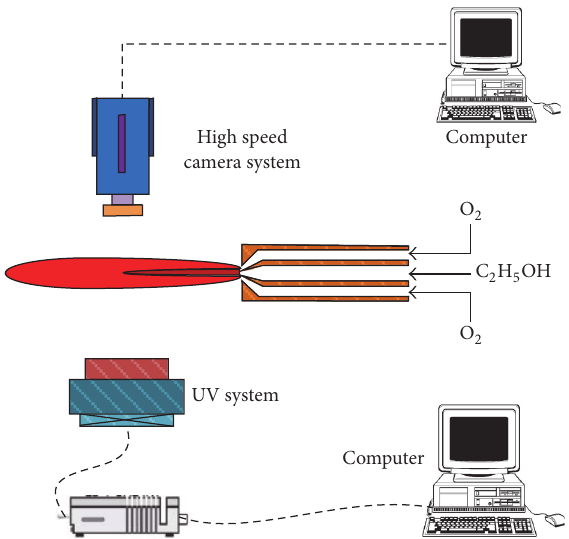
Figure 1: The schematic diagram of the experimental